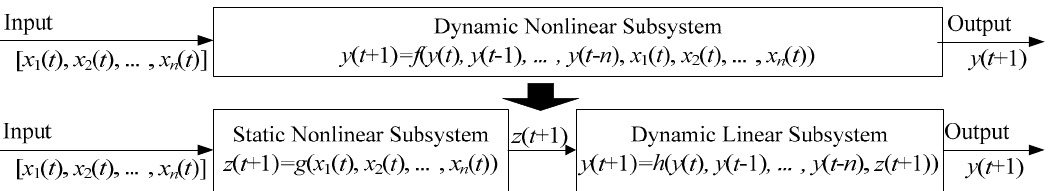
Figure 3. Operation of Hammerstein recurrent neural network (HRNN), in which the dynamic behavior in the time series is processed only by the linear dynamic module, whereas nonlinear behavior is processed only by the static nonlinear module.